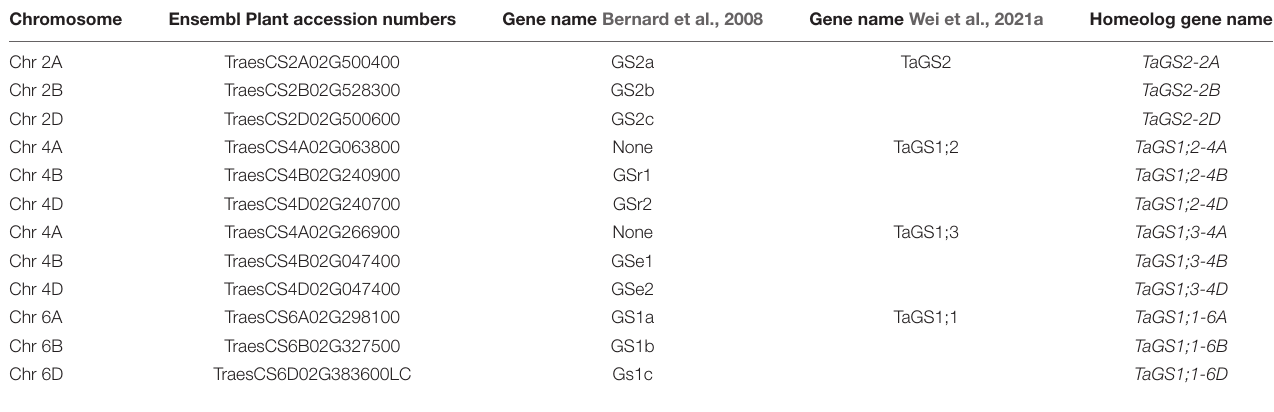
TABLE 1 | Putative glutamine synthetase (GS1 and GS2) genes from the Chinese Spring reference genome.